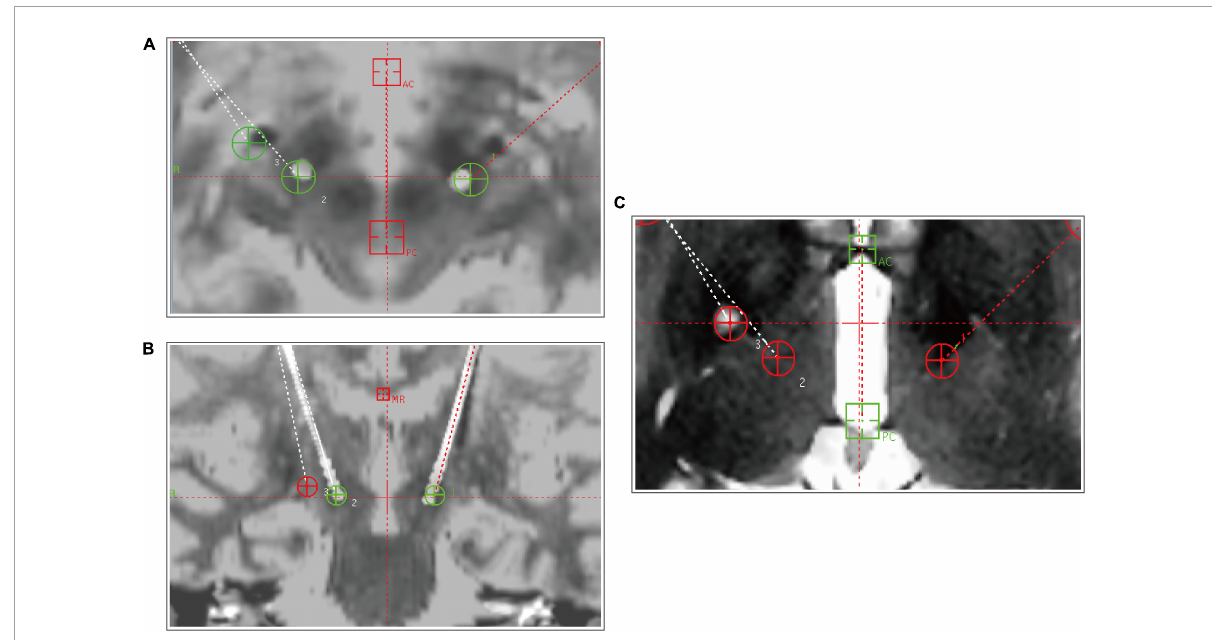
FIGURE1 Postoperative MR images of patient 5, demonstrating positions of the implanted electrodes in the bilateral STN (A,B) and unilateral pallidotomy. The two red orthogonal lines refer to the Cartesian coordinate system in each view, whereas the diagonal lines, with or without green circles, represent the trajectories of the implanted leads. In the center of each view, the two green circles (named 1 and 2) in (A,B) show the planned targets, and the one red circle (named 3) in (C) shows the position of pallidotomy. AC, anterior commissure; MR, midline reference; PC, posterior